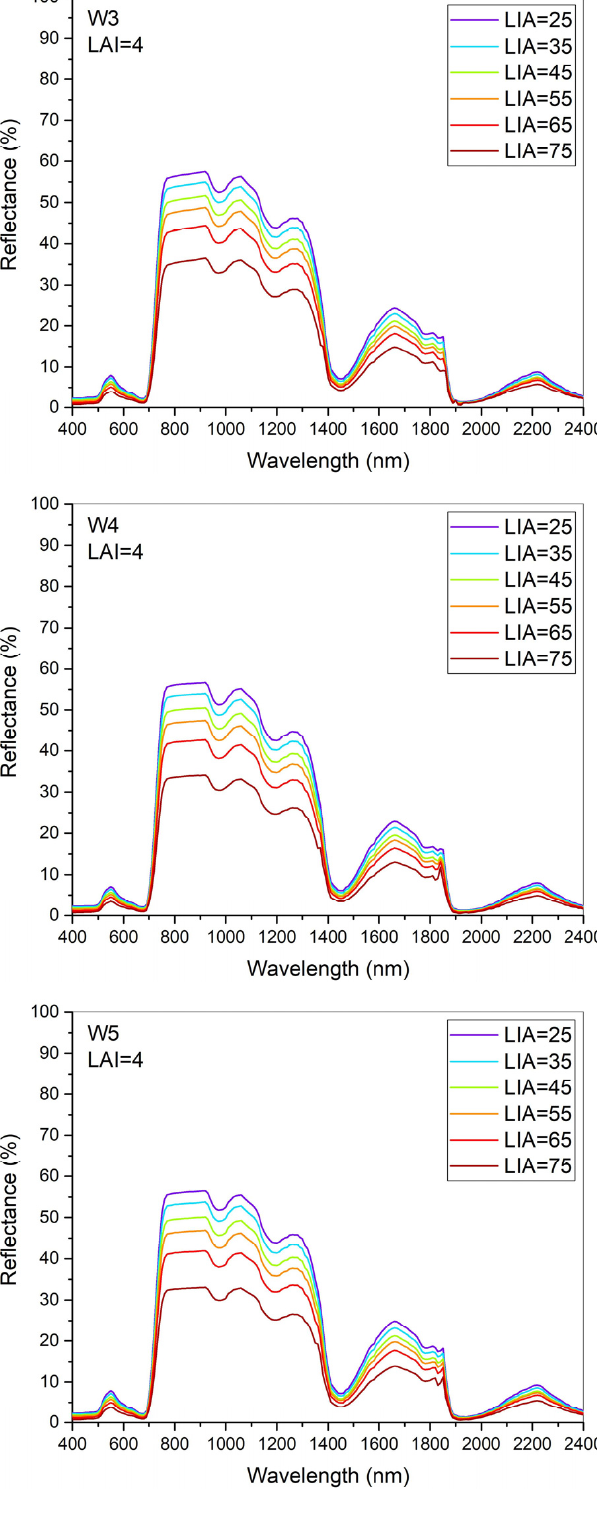
Figure 8. Influences of different LIA on canopy spectral reflectance under continuous water stresses.